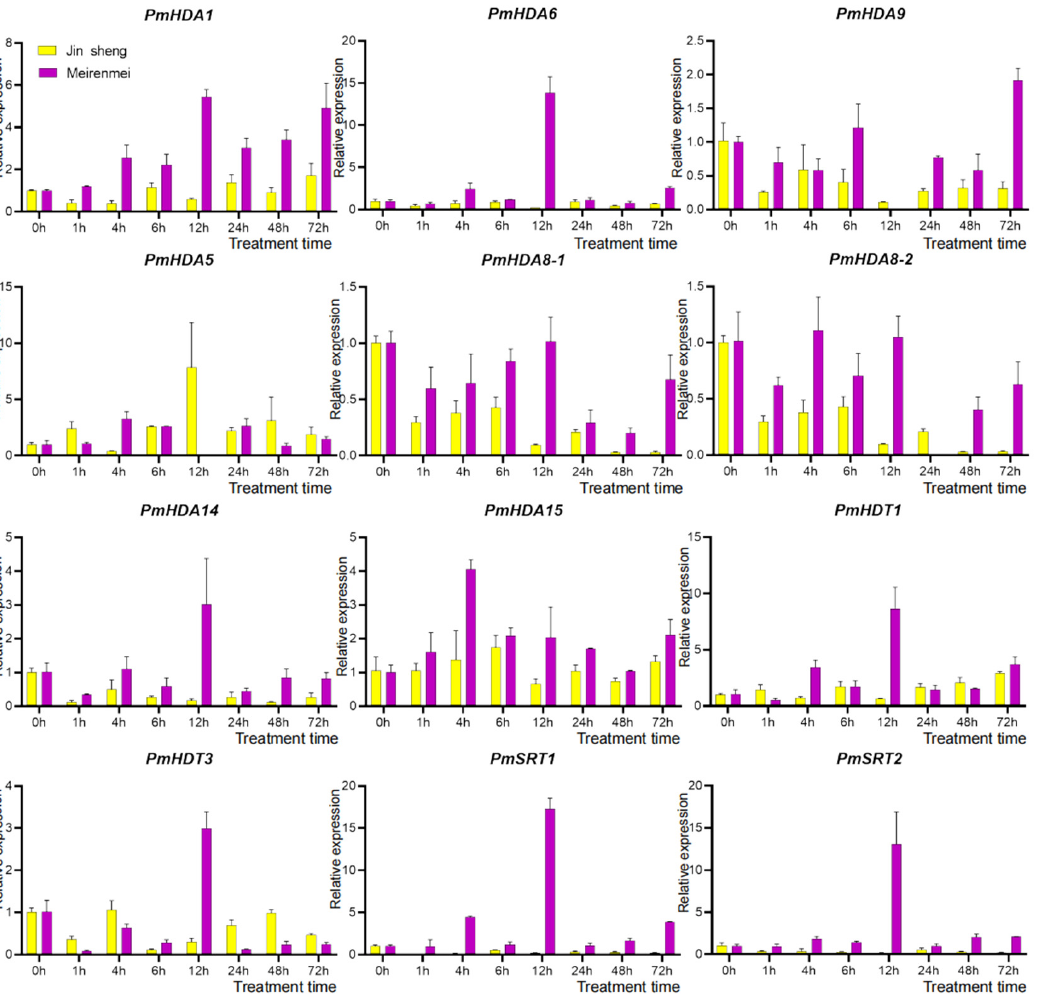
Figure 10. qRT-PCR analysis of PmHDACs in annual branch of cold-sensitive cultivar ‘Jinsheng’ and cold-insensitive cultivar ‘Meirenmei’ under low temperature treatment. Cold treatments were under 4 °C at 0, 1, 4, 6, 12, 24, 48 and 72 h. The yellow and purple represent cold-sensitive cultivar ‘Jinsheng’ and cold-insensitive cultivar ‘Meirenmei’, respectively.